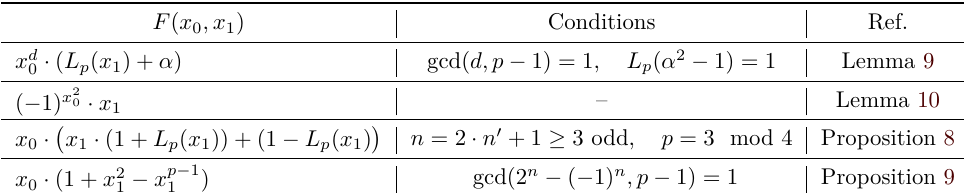
Table 2: List of functions F : F 2 for n ≥ 2 defined as in Definition 5 is